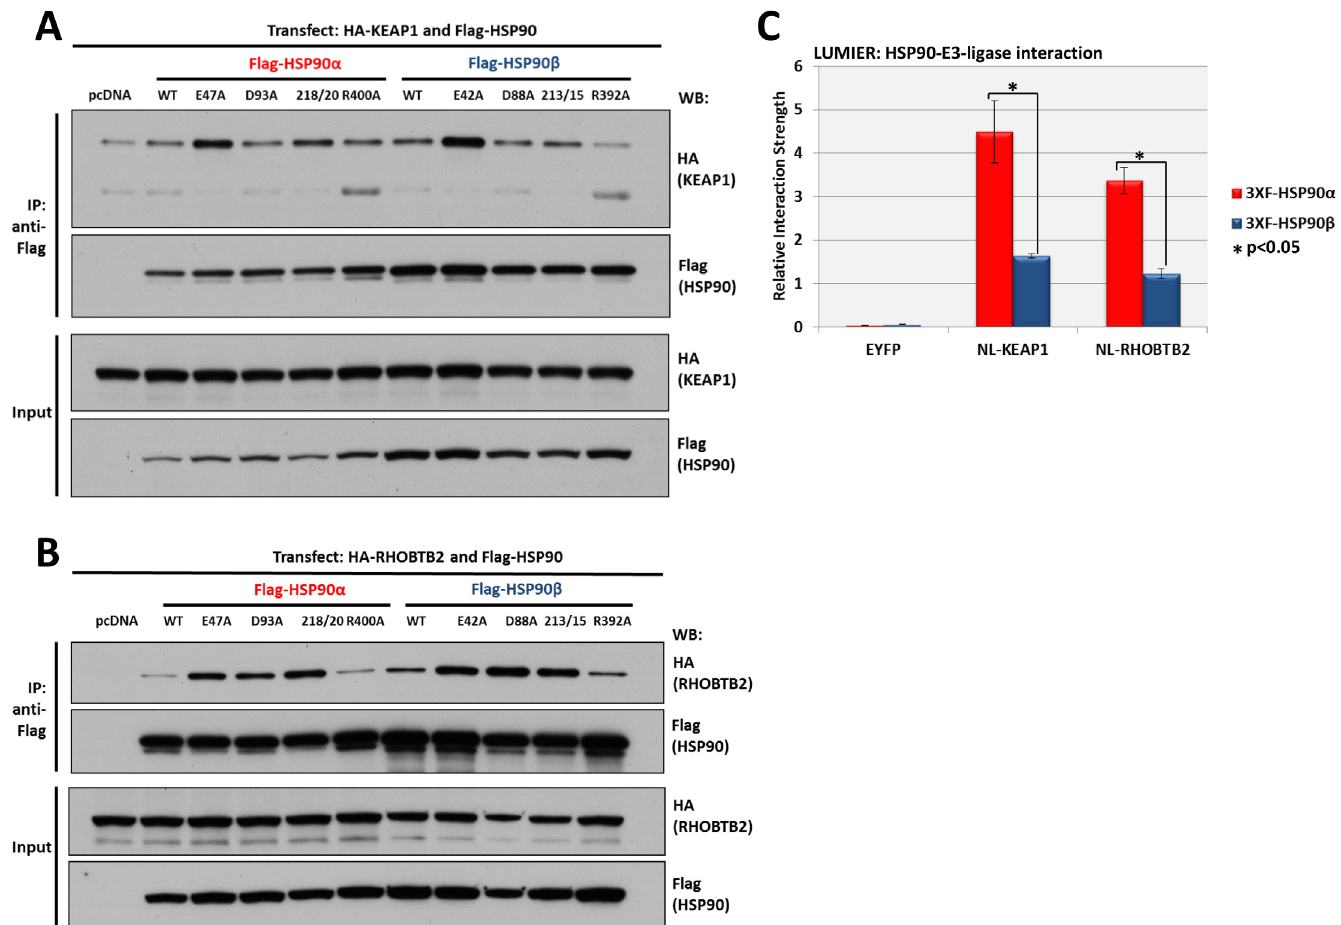
Fig 4. Interaction of KEAP1 and RHOBTB2 with HSP90 isoforms. (A) KEAP1interaction with HSP90 WT and mutants: HEK293 cells transfected with HA-KEAP1 and each FLAG-HSP90 construct were harvested, immunoprecipitated with anti-FLAG beads and western blotted for HA. Input lysates were normalized and run as controls. (B) RHOBTB2 interaction with HSP90 WT and mutants: HEK293 cells transfected with HA-RHOBTB2 and each FLAG-HSP90 construct were harvested, immunoprecipitated with anti-FLAG beads and western blotted for HA. Input lysates were normalized and run as controls. (C) Measurement of the relative interaction strength of KEAP1 and RHOBTB2 with each HSP90 isoform by LUMIER: HEK293 cells transfected with KEAP1 or RHOBTB2 and each HSP90 isoform were harvested, applied to a 96-well anti-FLAG plate and assayed for luciferase activity. The difference in relative interaction strength of HSP90 α and HSP90 β for KEAP1 and RHOBTB2 (each approximately 3-fold) was statistically significant (p < 0.05) (see